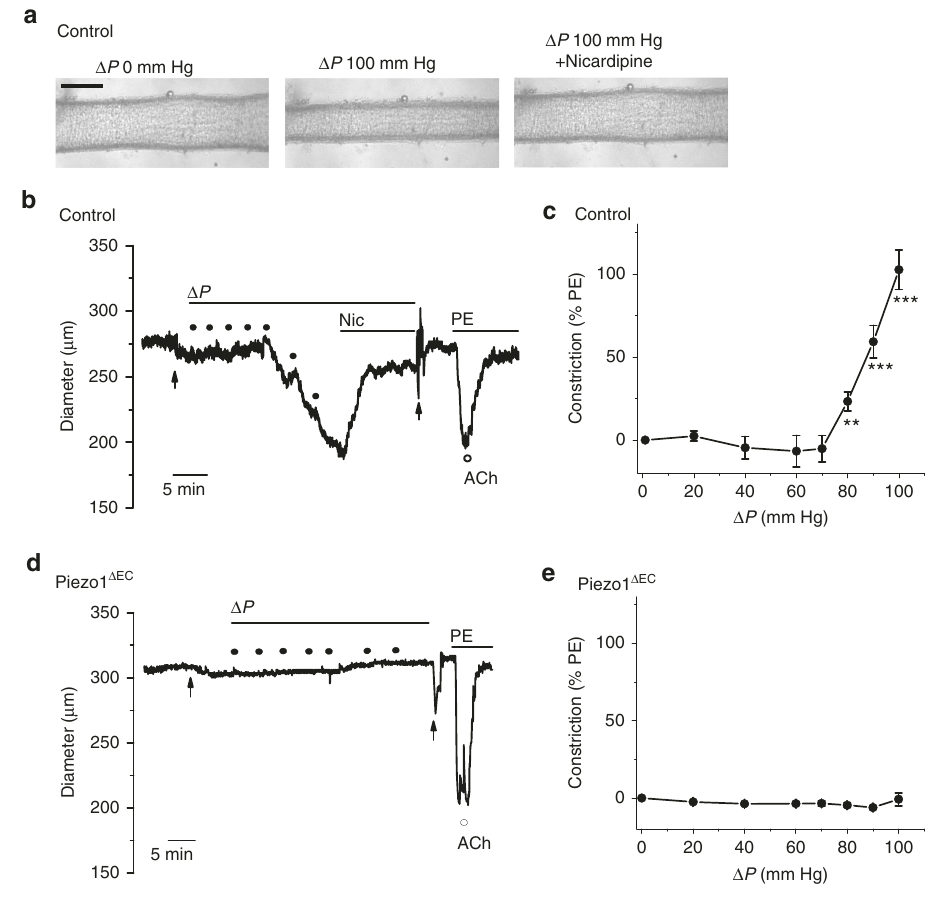
Fig. 6 Flow-evoked vasoconstriction in mesenteric artery. Isobaric external diameter recordings from second-order mesenteric artery. a Example images of a cannulated artery before and after luminal pressure difference ( Δ P ) and then after 10 μ M nicardipine was added to the recording chamber. Control genotype mouse. Scale bar , 200 μ m. b Example diameter recording for a control genotype mouse during incremental increases in Δ P as indicated by the black dots (20, 40, 60, 70, 80, 90 and 100 mm Hg). Nicardipine (Nic, 10 μ M), phenylephrine (PE, 1 μ M) and acetylcholine (ACh, 10 μ M) were applied